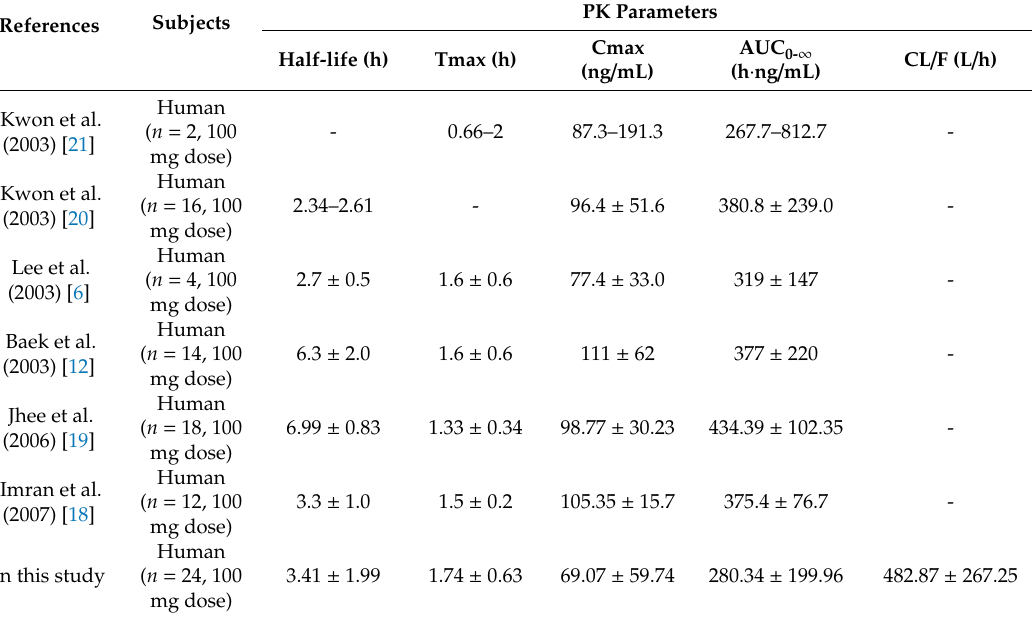
Table 8. Previously reported pharmacokinetic (PK) parameter values of tiropramide obtained by non-compartmental analysis (NCA)